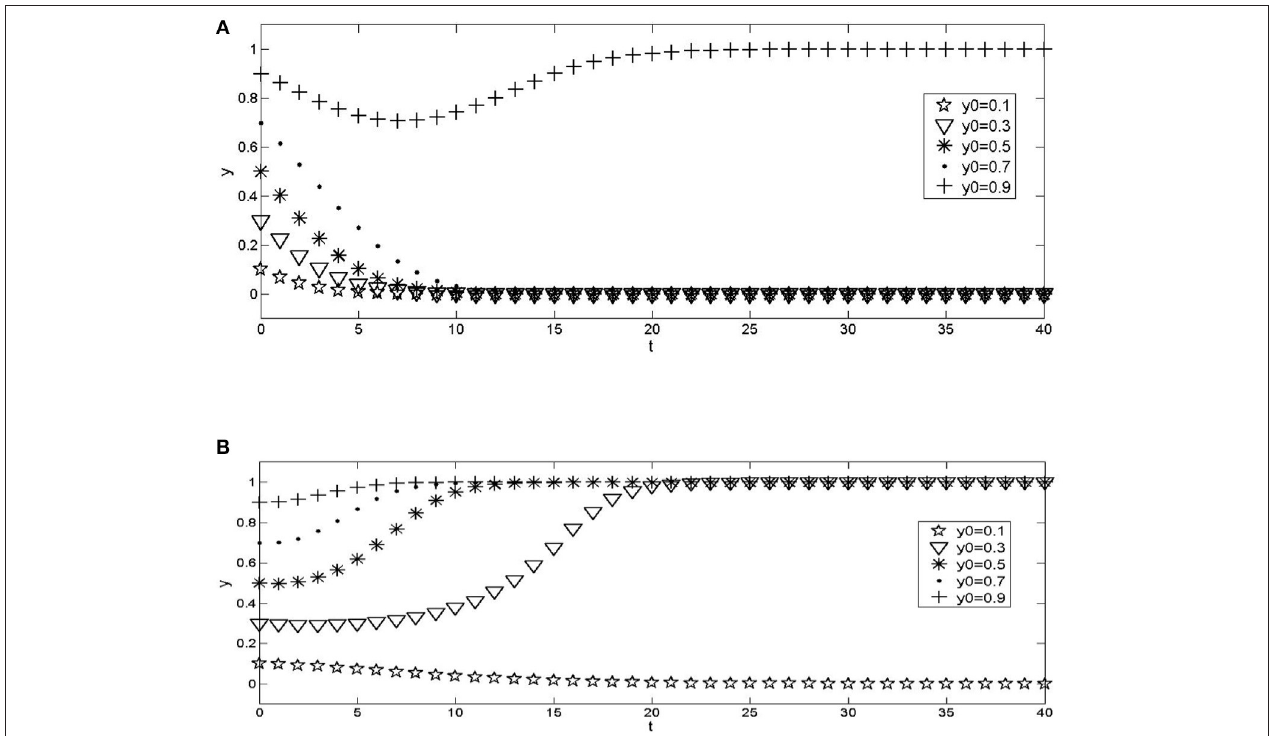
FIGURE 3 | Impact of changes in government supervision probability on evolution results. (A) a = 0.2; (B) a = 0.8.